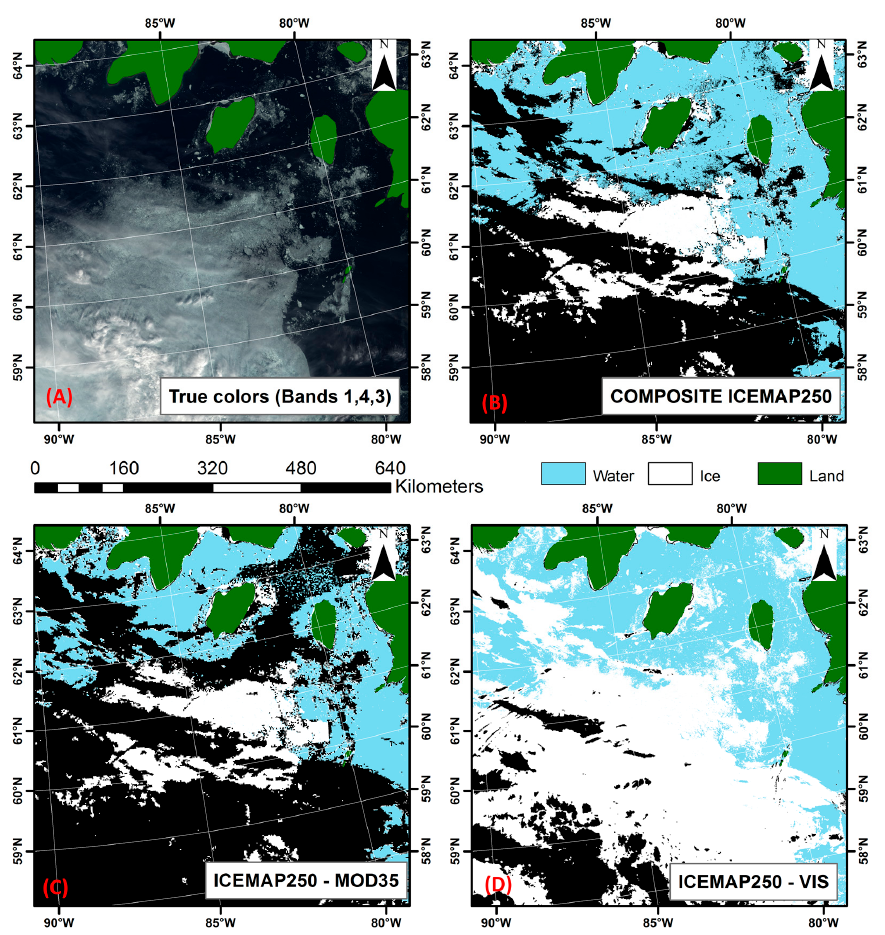
Figure 8. ( A – D ) An example of the composition process for 4 July 2009. The composite IceMap250 is the fusion of the water detected in IceMap250 with VIS and the ice detected in IceMap250 with MOD35. Cloudy pixels or pixels where the classification failed to provide a consistent result appear in black in the IceMap250 maps. (The IceMap250 maps are to be made available to users through the IcePAC web interface at http://icepac.ete.inrs.ca.) The second product, the weekly synthesis map, shows the state of the ice cover as calculated by applying a majority filter to the ice conditions recorded for the previous seven days. Time-series records of ice conditions are built for every pixel using the composite maps, and the condition that appears in the majority of cases is mapped. In the case of equality between water and ice, the pixel is tagged as no data. A minimum of three occurrences is needed for the algorithm to map the majority case.